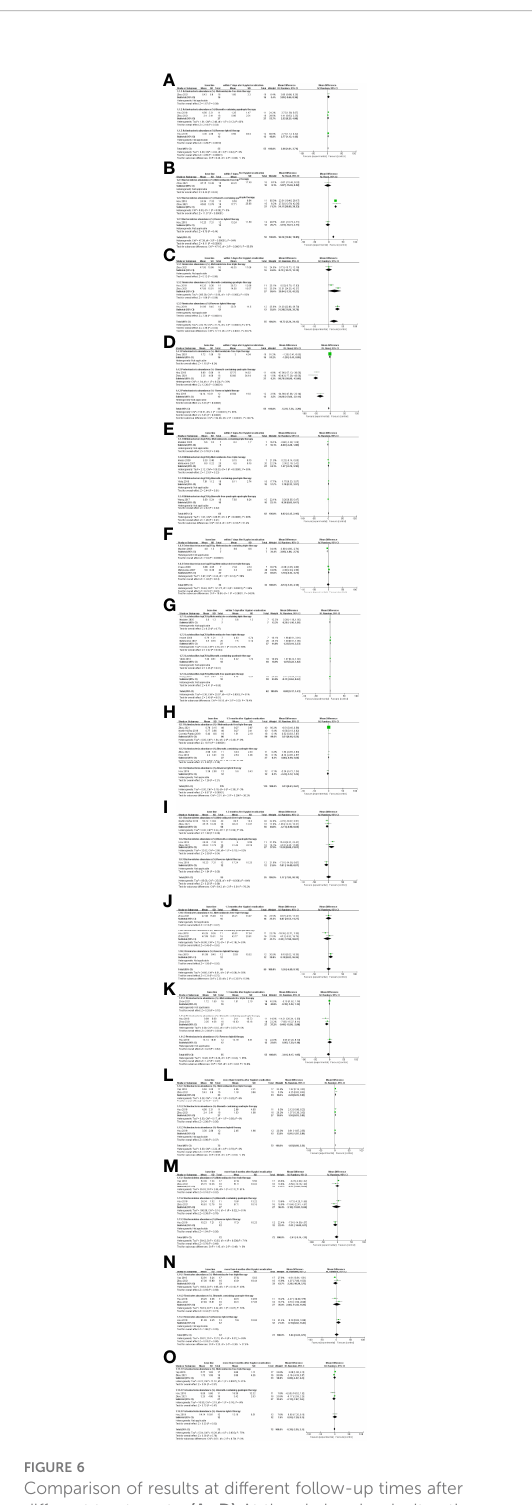
FIGURE 6 Comparison of results at different follow-up times after different treatments. (A – D) At the phylum level, alterations in gut microbiota within 7 days. (E – G) At the family and genus levels, alterations in gut microbiota within 7 days. (H – K) Alterations in gut microbiota at 1 – 3 months. (L – O) Alterations in gut microbiota more than 6